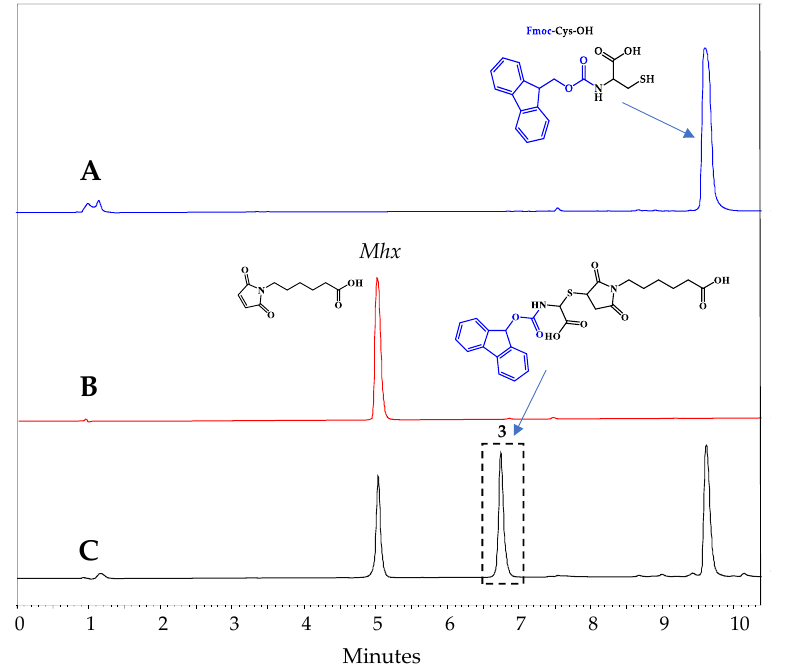
Minutes Figure 6. Fmoc-Cys-OH and Mhx reaction. Monitoring by RP-HPLC: panels ( A , B ) correspond to Figure 6. Fmoc-Cys-OH and Mhx reaction. Monitoring by RP-HPLC: panels ( A ) and ( B ) correspond to starting material, panel ( C ) shows the reaction mixture. starting material, panel ( C ) shows the reaction